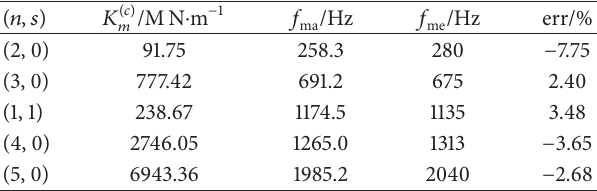
Figure 7: Response by stator system natural frequency experiment. Table 4: Calculation and test results for natural frequencies of stator core of 15 kW